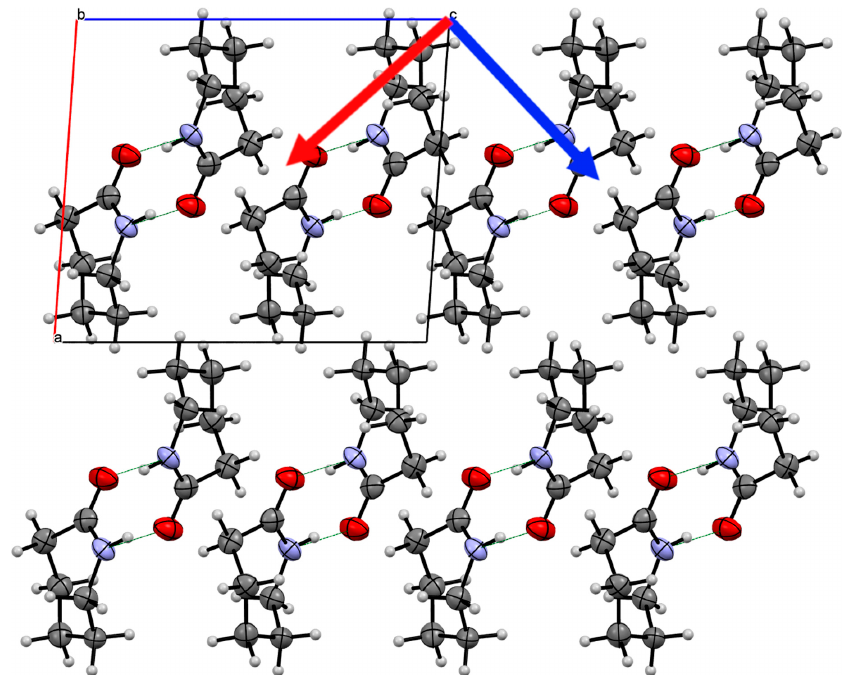
Figure 7. Crystal structure of Form III caprolactam viewed down the b -axis indicating the two of the principal components of strain (Red arrow 11.2(2) TPa − 1 ; Blue arrow 10.3(3) TPa − 1 ). The third component is along the b -axis. The two directions indicated are the most compressible in the structure. The packing of the chains is much greater than in Form II and the chains interlock to a greater extent. This allows the compression of the chains together, which reduces the compression of the hydrogen bonded chain (along the b -axis).